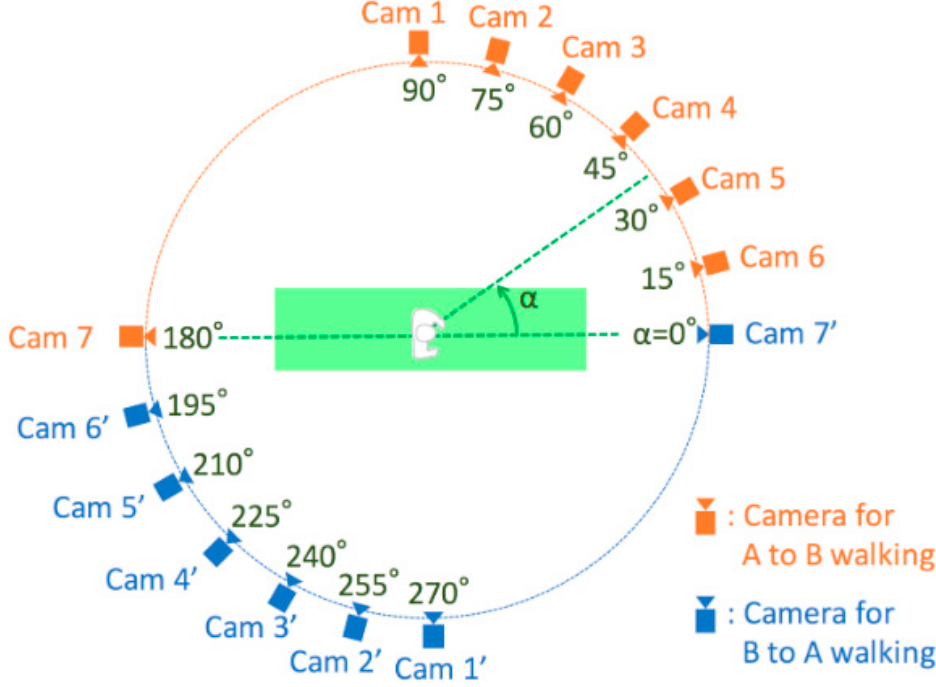
Figure 6. Illustration of gait capturing of OU-MVLP dataset (Adapted with permission from ref. [53] 2021, Yasushi Makihara).